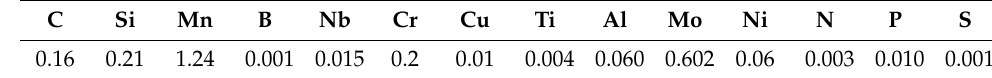
Table 3. Real chemical composition of the given series of S960QL steel.